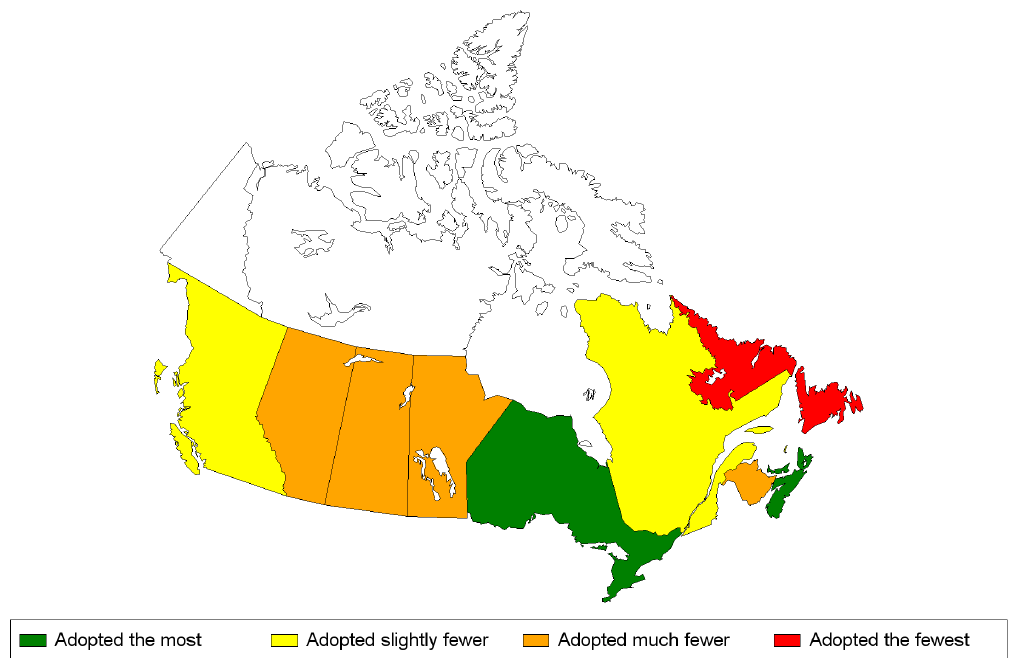
Figure 5. Provinces’ classification according to the four categories of pro-environmental behaviours, Indoor Index, 2007. Legend : from left to right – British-Columbia, Alberta, Saskatchewan, Manitoba, Ontario, Quebec, New-Brunswick, Nova-Scotia. Prince-Edward-Island is North of the two latter provinces and Newfoundland-and-Labrador is located North-East of Quebec.